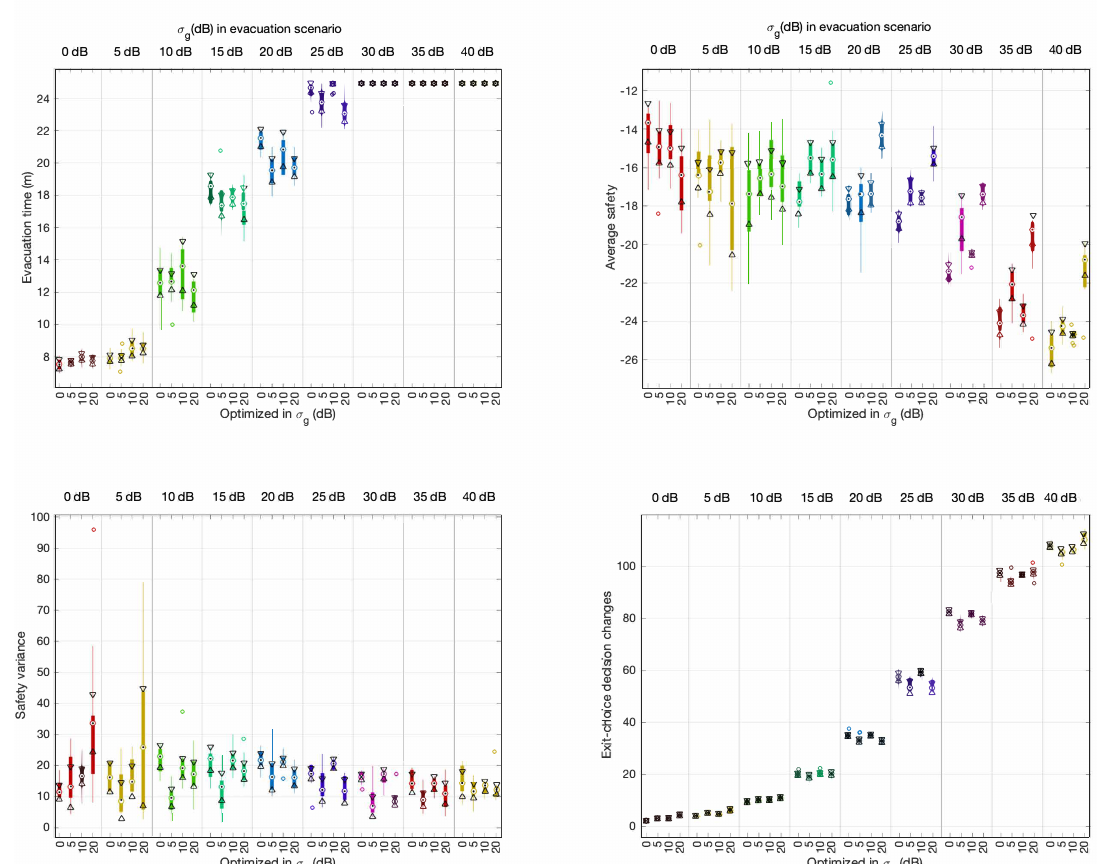
Figure 13. Median box-plots of the performance measurements of the optimal configurations of CellEVAC for σ g = 0,5,10,20 dB, in evacuation scenarios with external pedestrian flows and with positioning uncertainty levels from 0 dB to 40 dB in steps of 5 dB. Bottom horizontal axes categorize the optimal configuration of parameters used (0, 5, 10, or 20 dB) to configure CellEVAC. Upper horizontal axes categorize the σ g value that models the positioning system in the evacuation